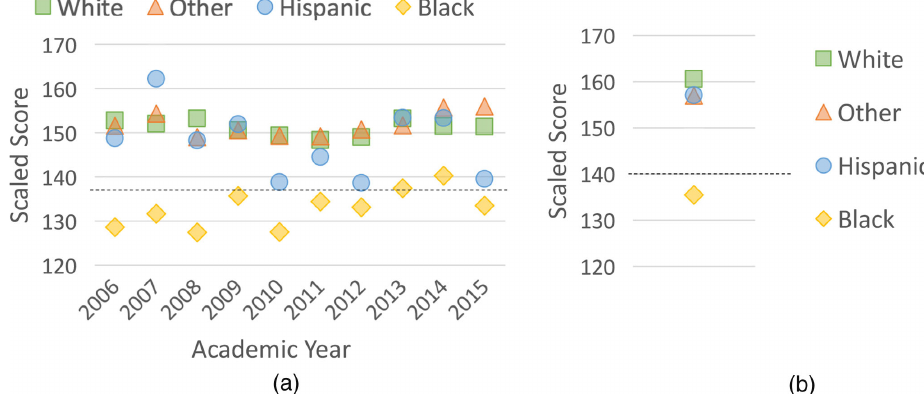
FIG. 5. Praxis physics subject assessment performance by (a) examinees ’ reported race or ethnicity and (b) the reported race or ethnicity of physics and engineering majors. Scaled score is plotted on the y axis. Dashed line represents the national median passing score of 140. Source: Derived from data provided by the Educational Testing